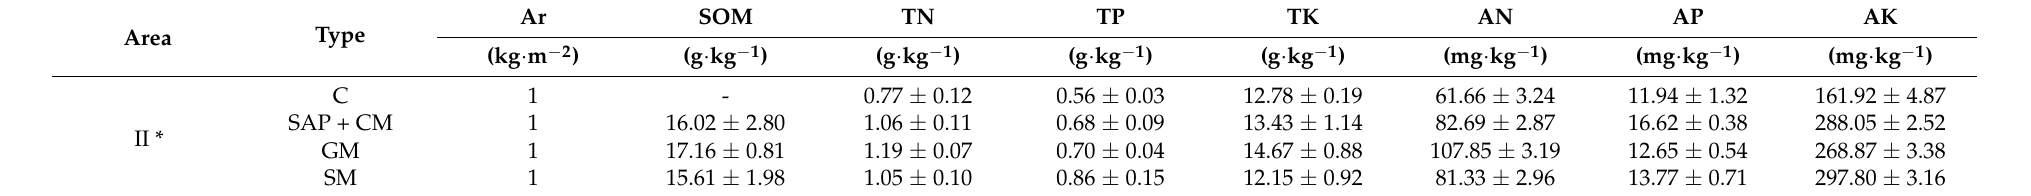
Table 4. Average (avg) and standard deviation (SD) values of some soil chemical properties computed for each mulch. Here, the effective use of soil mulching in the karst region of southern China is shown, reporting the following types of soil conservation techniques: ( a ) control (C), ( b ) super-absorbent polymer + cobblestone mulching (SAP+ CM), ( c ) grass mulching (GM), ( d ) straw mulching (SM). Direct comparisons were made for each mulching during the rainy season in 2022. The variables compared were the following soil nutrient: ( a ) mulch application ratio (i.e., specific value) (Ar), ( b ) soil organic matter (SOM), (c) total nitrogen (TN), obtain these data are experiments and instrument detection. The depth of the soil layer to obtain these data is 0–180